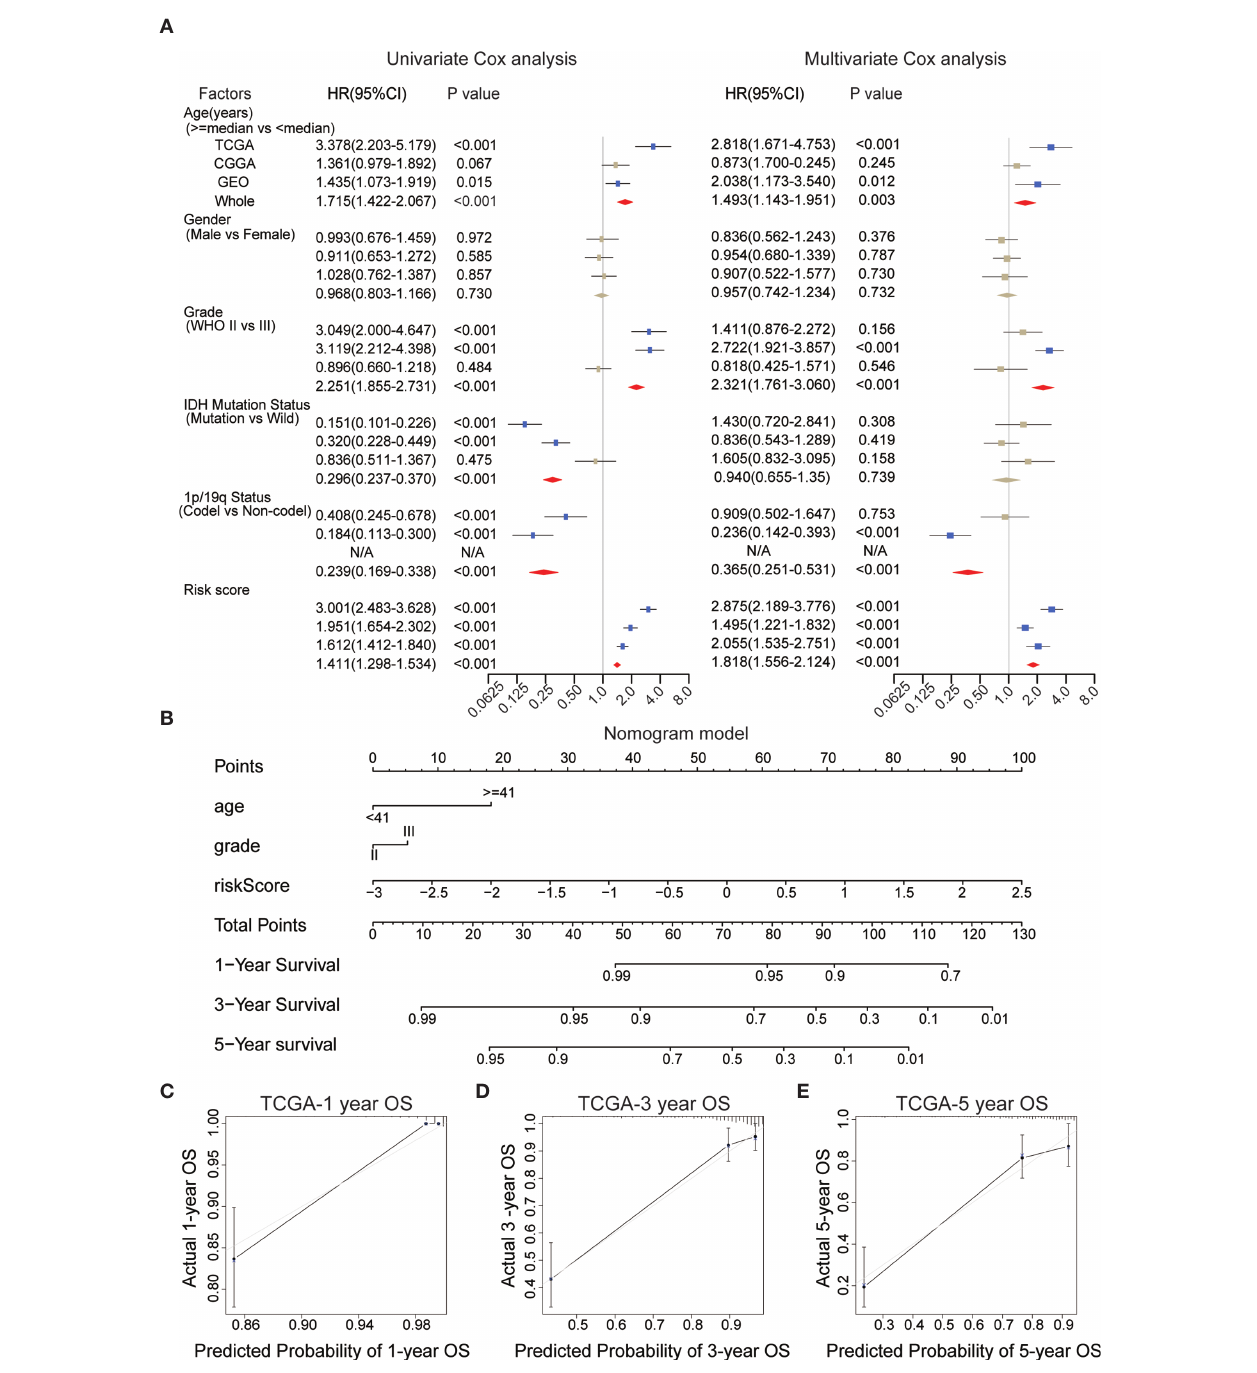
FIGURE 5 | (A) Univariate and multivariate Cox analyses of clinicopathological and molecular features, including age, gender, WHO grade, IDH mutational status, 1p/19q co-deletion status, and risk scores, in each dataset. (B) A nomogram was established to predict the overall survival (OS) of primary low-grade glioma (LGG) patients at 1/3/5 years. (C – E) Calibration curves for the nomogram for predicting the OS probability at 1/3/5 years among primary LGG patients in the TCGA dataset. WHO, World Health Organization; IDH, isocitrate dehydrogenase; TCGA, The Cancer Genome